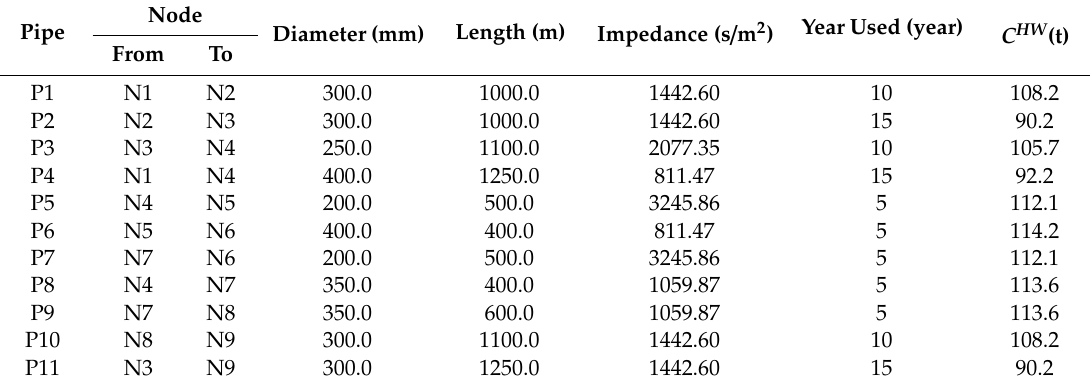
Table 4. The characteristics of the synthetic water distribution network (WDN) (pipe network